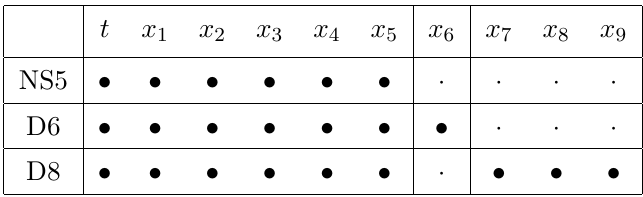
Table 1. The generic brane set-ups. All the branes are extended on the Minkowski R 1 ; 5 directions. The D6-branes also extend over x 6 where they have (cid:12)nite size extension between NS5-branes. The D8-branes also extend along the x 7 ; x 8 and x 9 directions, preserving the SO(3) R